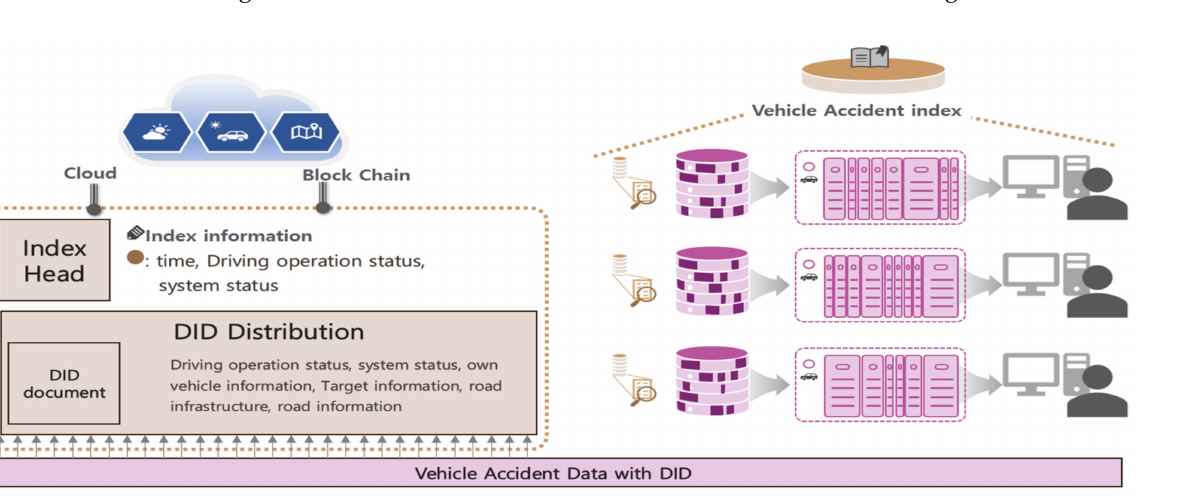
Figure 4. Vehicle Accident Data DID Distribution on